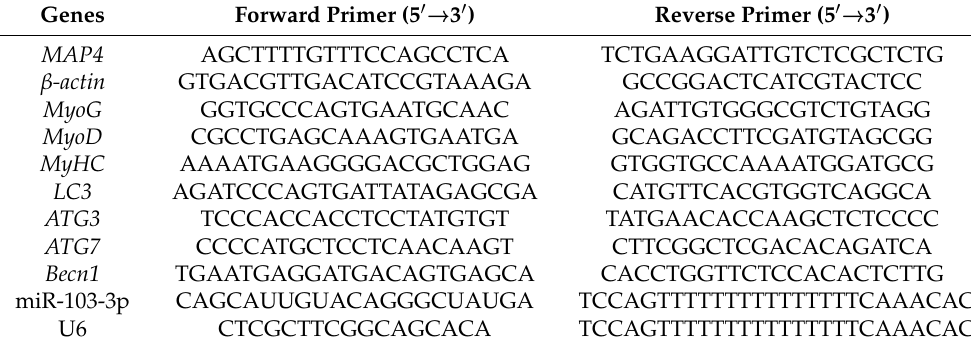
Table 1. Primers for